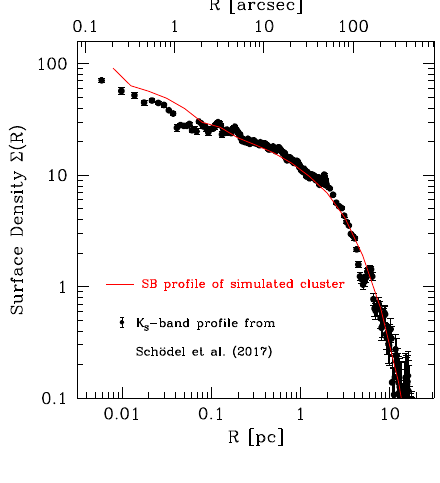
Fig. 48 Comparison of the observational data of the surface luminosity profile of the diffuse light of the galactic centre by Schödel et al. (2018) with a direct-summation N -body simulation (red line). Image reproduced by permission from Baumgardt et al. (2018), copyright by